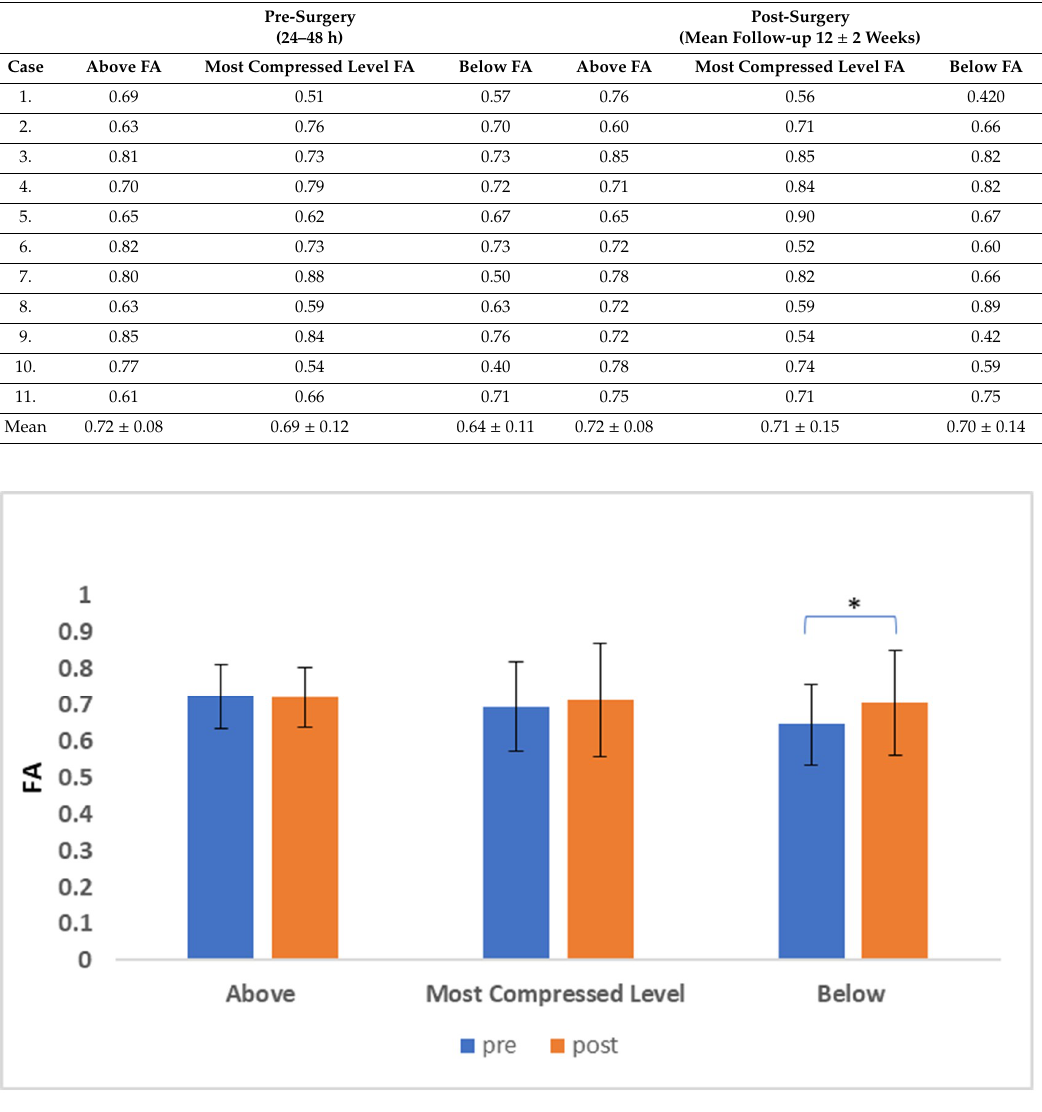
Figure 3. FA values of the most compressed level, the site of surgery, and the anatomical levels immediately above and below. Data are shown as mean values. The FA corresponding to the pre-surgery evaluation are shown in blue, whereas the FA corresponding to the post-surgery evaluation are shown in orange. Significant di ff erences are shown with * ( p <